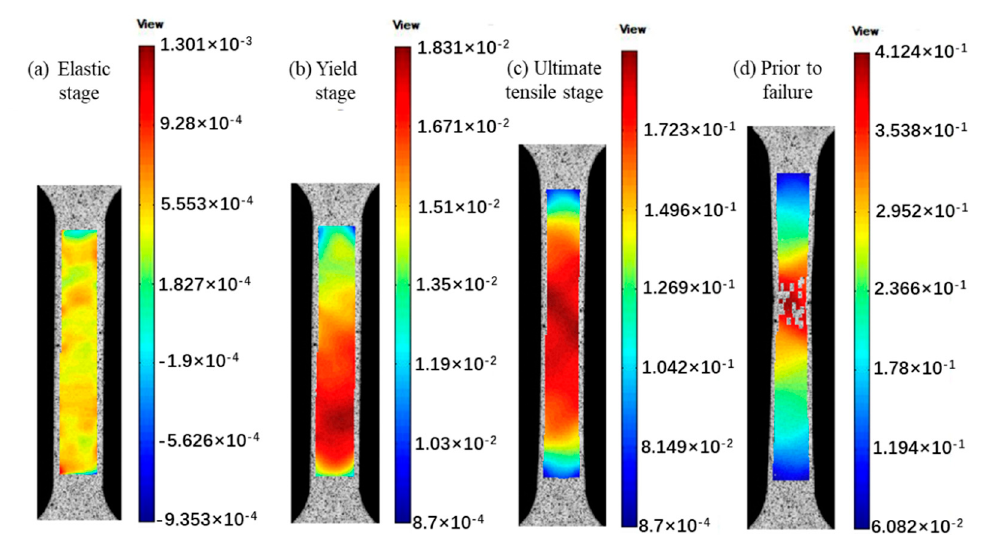
Figure 5. Strain contour plots of uniaxial RD tensile sample at various load steps: ( a ) initial stage, ( b ) yield stage, ( c ) ultimate tensile stage, ( d ) prior to failure.